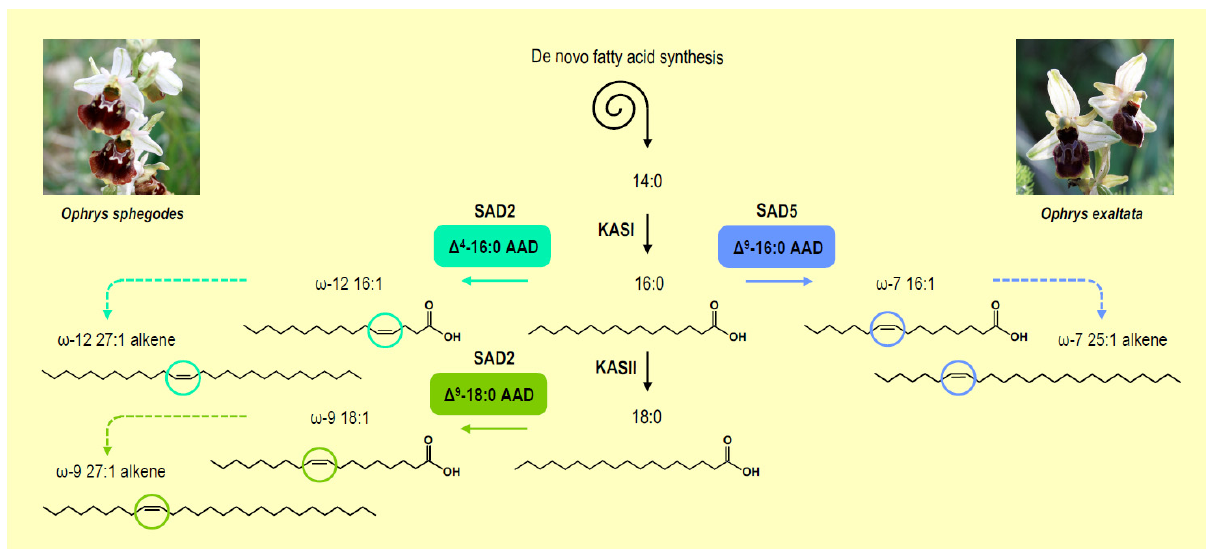
Figure 5. Biosynthesis of alkenes in Ophrys sphegodes and Ophrys exaltata. The simplified scheme depicts the different pathways involved in the biosynthesis of fatty acids and alkenes in the epidermal cell layer of the labellum in Ophrys sphegodes and Ophrys exaltata . Different types of acyl–acyl carrier protein desaturases with contrasted substrate specificities and regiospecificities produce different categories of monounsaturated fatty acids in the Ophrys species considered. As a consequence, different types of alkenes are synthesized and used as semiochemicals that attract different pollinators. AAD, acyl–acyl carrier protein desaturase; KAS, fatty acid synthase complex comprising 3-ketoacyl-ACP synthase. Picture credit: [130,131].